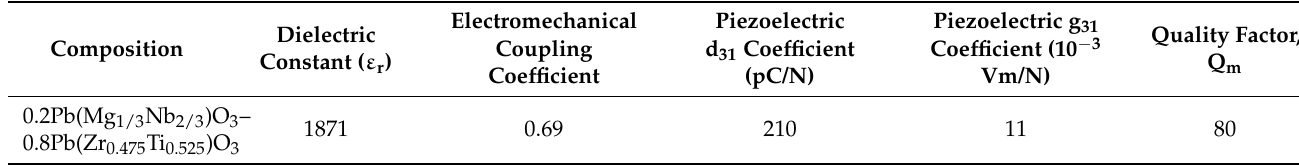
Figure 1. Geometry of piezoelectric cantilever-type generator and its arrangement. ( a ) Geometry; ( b ) Piezoelectric generator; ( c ) Measurement of piezoelectric generator. Table 2. Property of piezoelectric